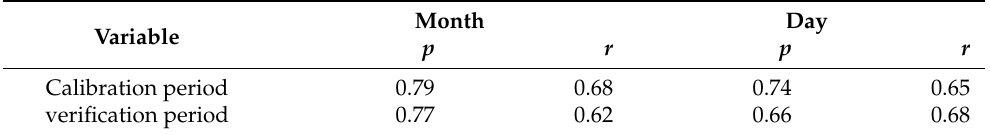
Table 4. Statistical table of p -factor and let-factor analysis results.